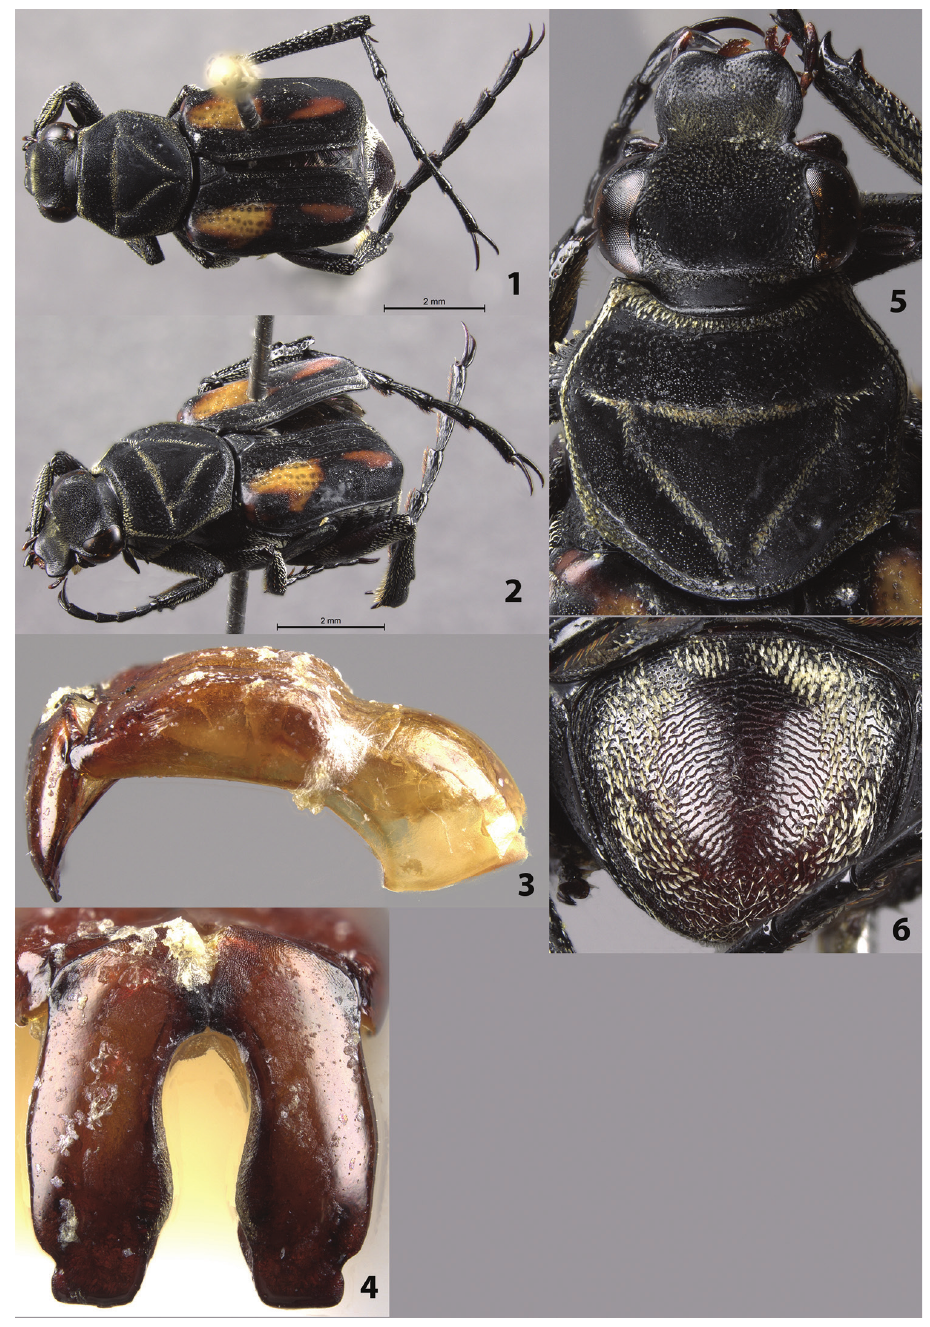
Figures 1–6. Trigonopeltastes arborfloricola sp. n., male holotype. 1 Dorsal habitus 2 Oblique habitus 3 Lateral genitalia 4 Parameres 5 Head and pronotum 6